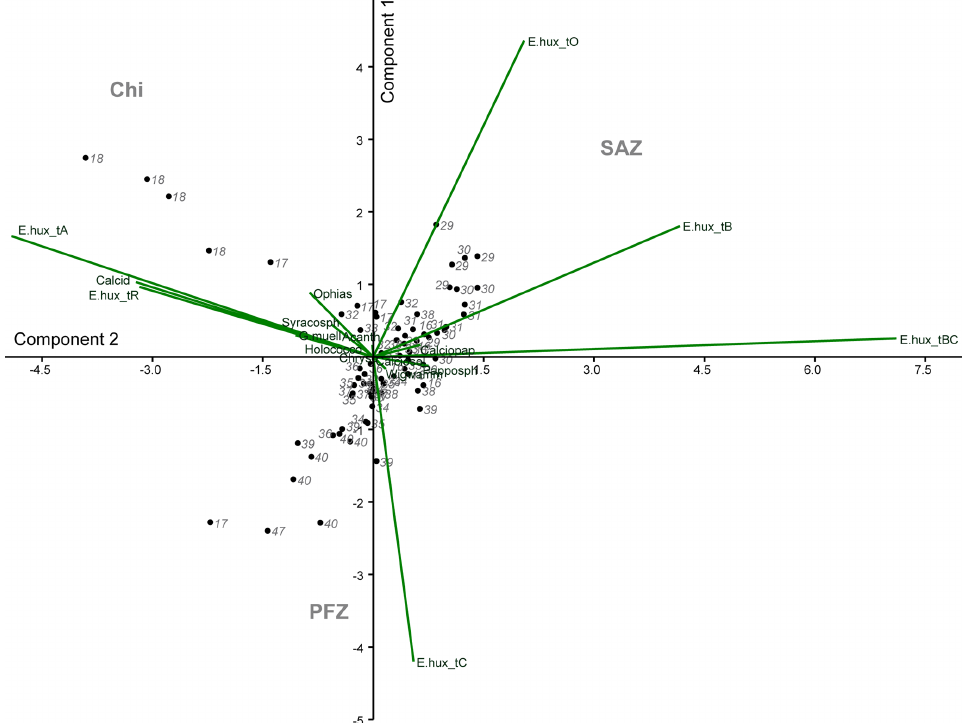
Figure 8. Principal component analysis (PCA) biplot performed on the coccolithophore dataset. The two main components (PC1 – y axis – and PC2 – x axis), coccolithophore taxa, station numbers and the different clusters are indicated. The following abbreviations are used in the figure: E.hux_tA ( E. huxleyi type A), E.hux_tB ( E. huxleyi type B), E.hux_tBC ( E. huxleyi type B/C), E.hux_tC ( E. huxleyi type C), E.hux_tO ( E. huxleyi type O), E.hux_tR ( E. huxleyi type R), Calcid ( Calcidiscus s.l.), Acanth ( Acanthoica quattrospina ), Calciopap ( Calciopappus caudatus ), Calciosol ( Calciosolenia murrayi ), Chryso ( Chrysotila sp.), G.mueller ( G. muellerae ), Holococco (holococcolithophores), Ophias ( Ophiaster spp.), Papposph ( Papposphaera sp. and Pappomonas spp.), Syracosph ( Syracosphaera spp.), Wigwamm ( Wigwamma antarctica ), SAZ (Subantarctic Zone), PFZ (Polar Front Zone) and Chi (Chilean coastal zone).